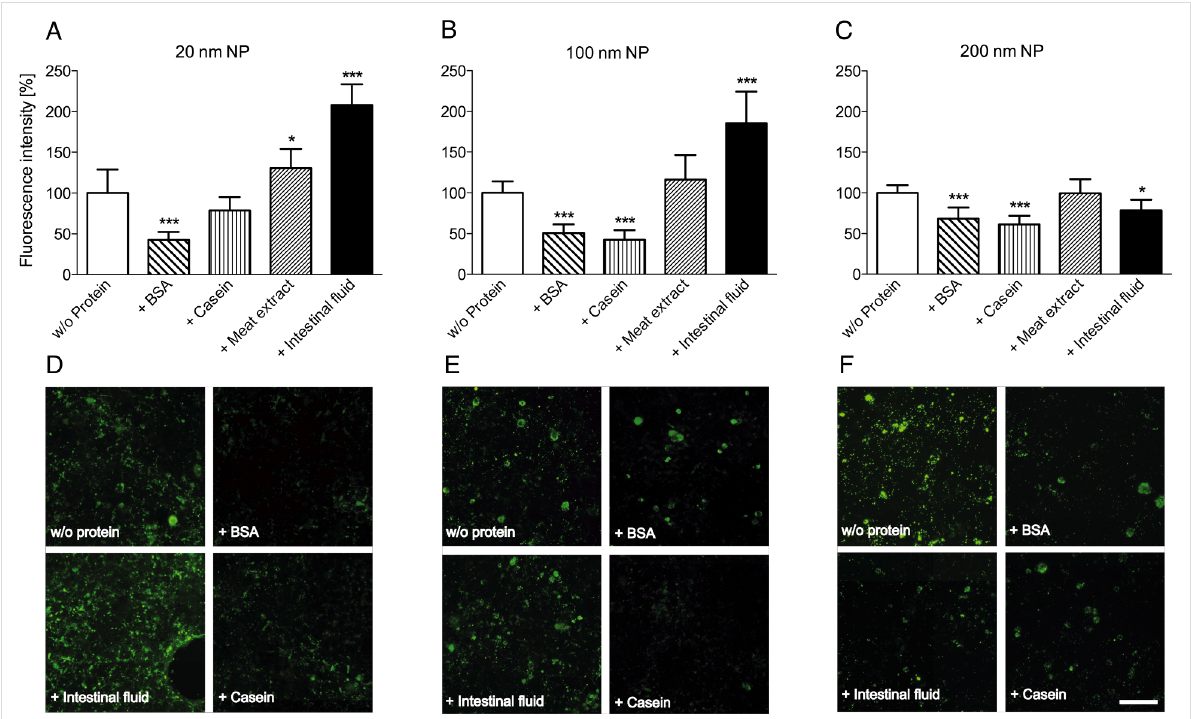
Figure 2: Interaction of fluorescent NPs with Caco-2 cells in the presence of proteinaceous compounds. Differently sized NPs, without or with pretreatment with different protein mixtures, were incubated with Caco-2 cells. After extensive washing, particle adherence to and/or uptake by the cells was determined by fluorescence microscopy. Values were normalized to intensities obtained with untreated particles (A, B, C; mean + SD of 6–8 individual experiments; p < 0.05 (*) and p < 0.001 (***), ANOVA with Dunnett’s post-hoc test). En-face fluorescence microscope images (D, E, F) show variations in NP adherence, depending on the pretreatment with proteins. Scale bar, 100 µm.